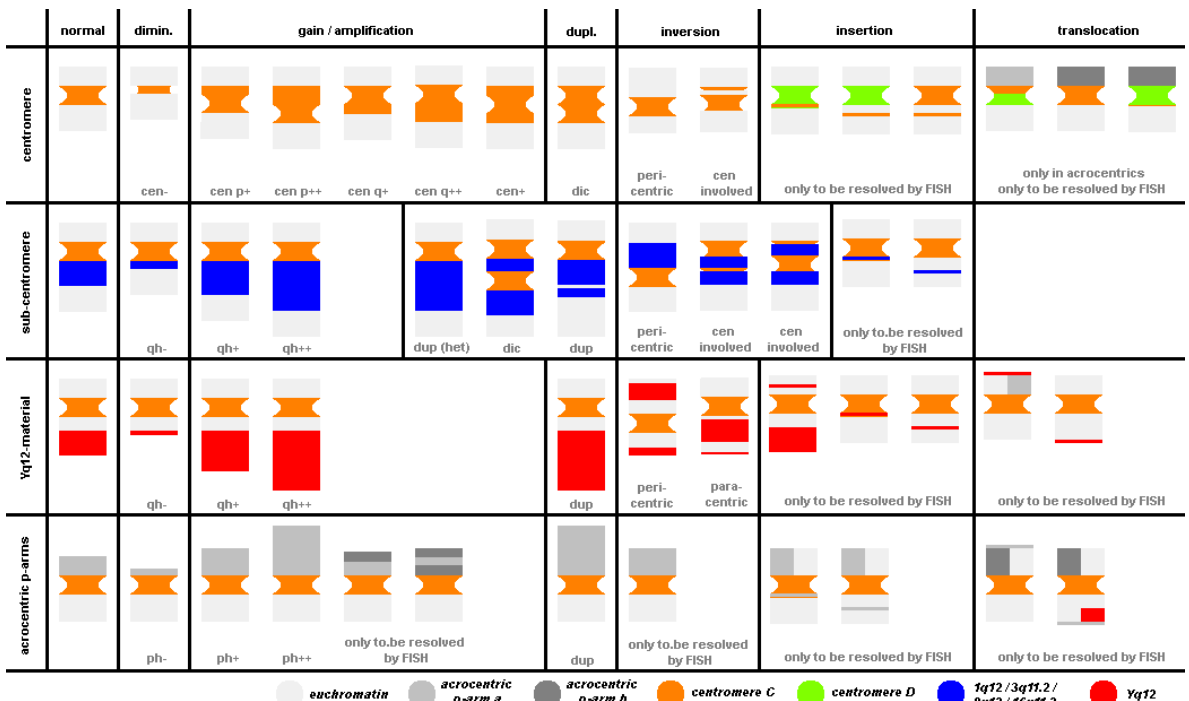
Figure 2. Heterochromatic CG-CNVs can lead to different deviations in chromosome shape and size. Centromeres (line 2), subcentromeric regions — mainly 1q12, 3q11.2, 9q12, and 16q11.2 (line 3), band Yq12 (line 4), and the short arms (p-arms) of the acrocentric chromosomes (line 4) can be involved. The normal status is presented in column 2; reduction in size (dimin.), gain/amplification, duplications (dupl.), inversions, insertions, and translocations of heterochromatic material are shown in the following columns. The colors represent different chromosomal regions as explained in the legend at the bottom of the figure.